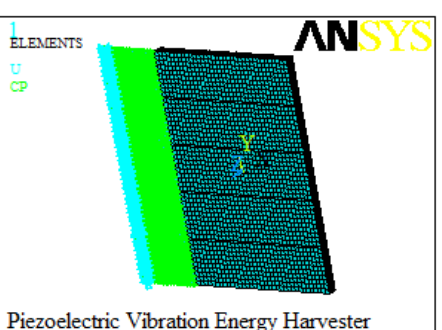
Figure 2. Finite element